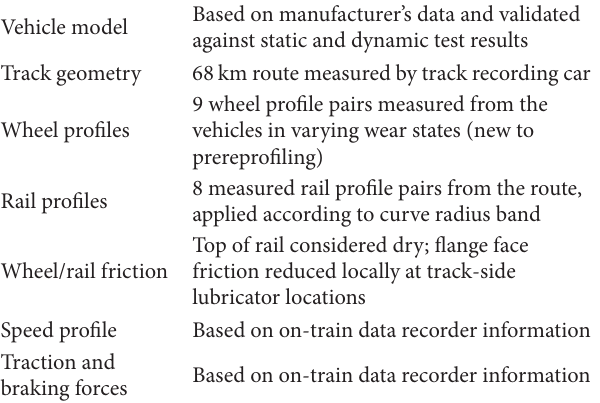
Table 1: Inputs to Vampire dynamic simulations.